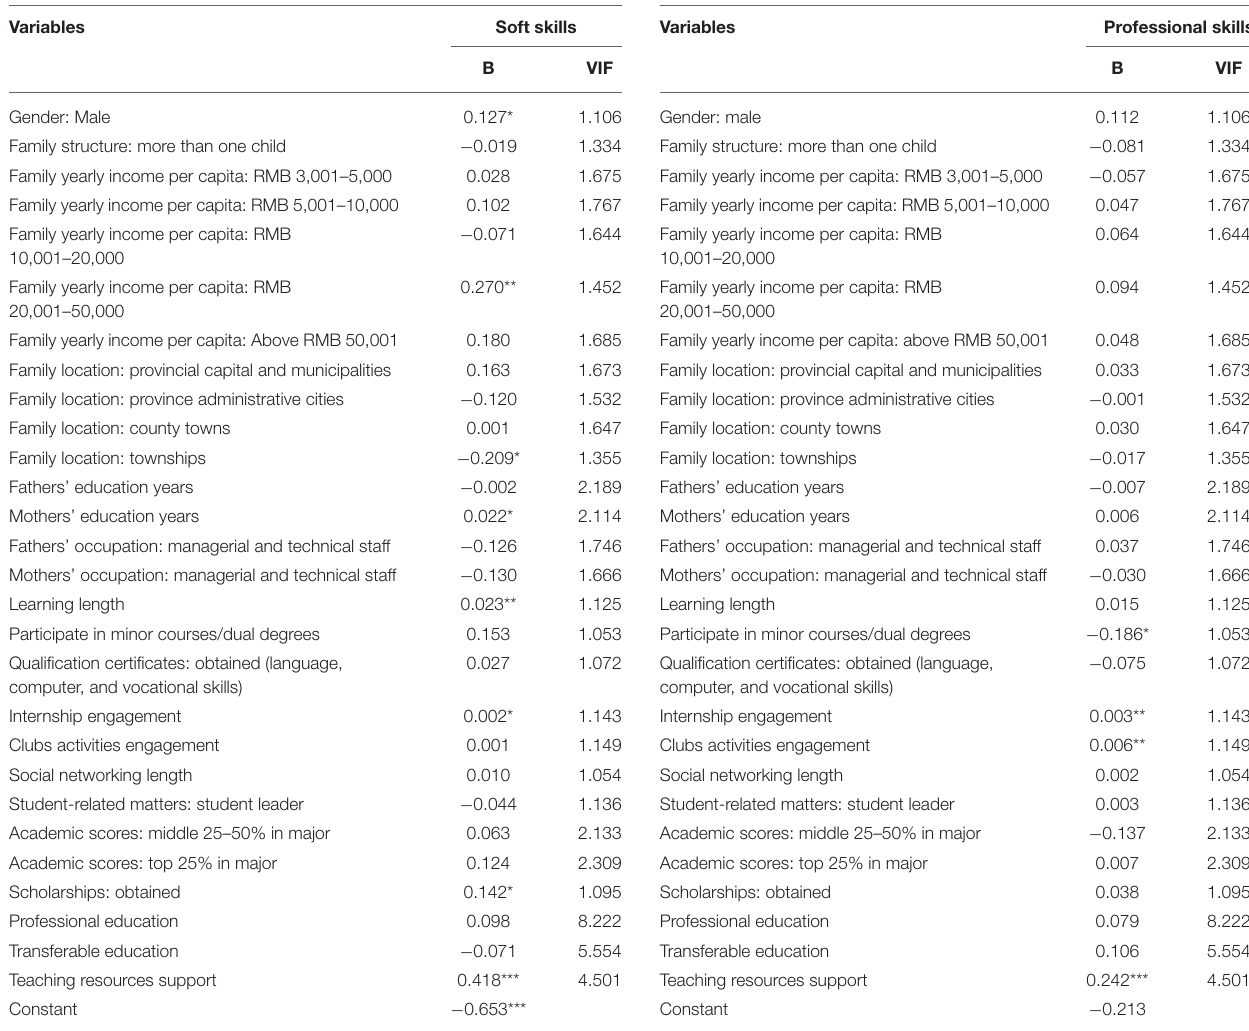
TABLE 6 | Factors impact on finance and trade graduates’ professional